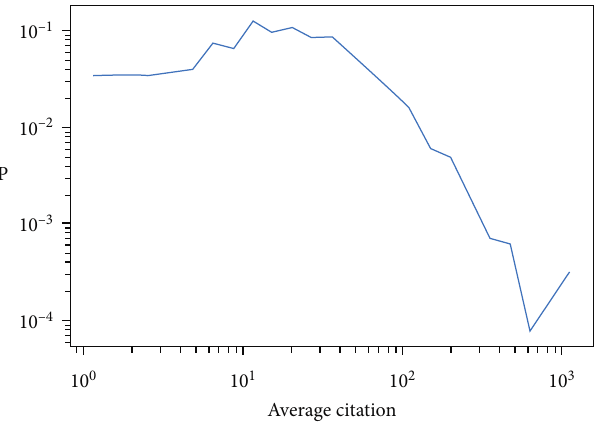
Figure 2: Distribution of average citations per